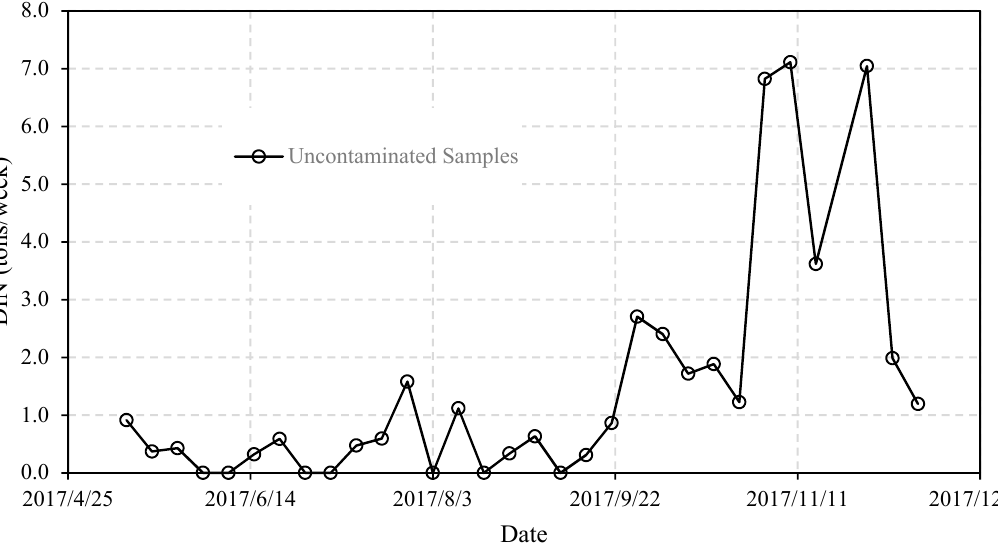
Figure 9. DIN lower estimates of weekly loadings (uncontaminated samples).